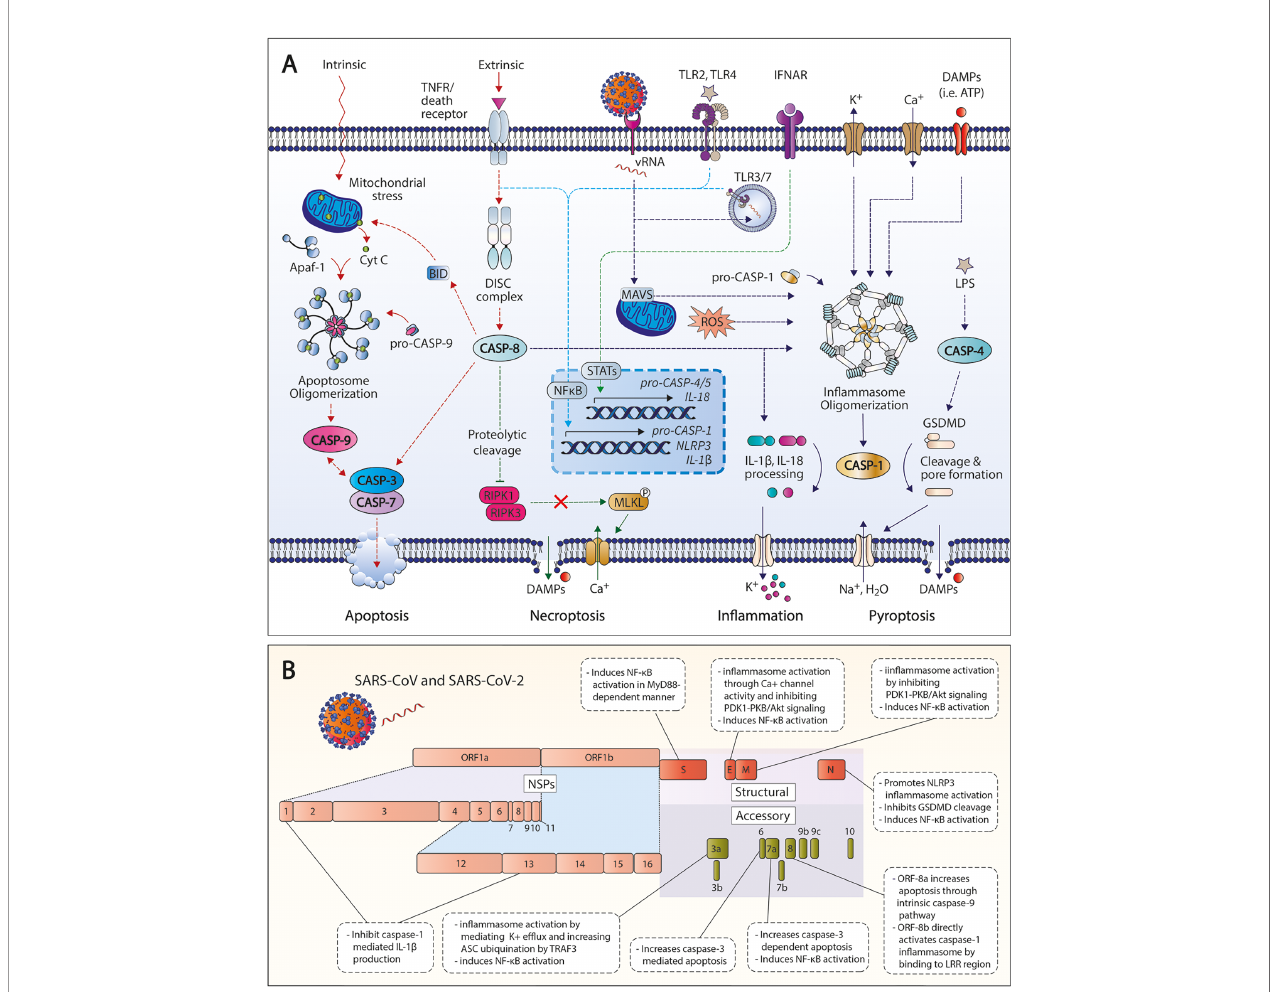
FIGURE 1 | Activated caspase pathways in SARS-CoV-2. (A) Apoptotic and in fl ammatory pathways associated with caspases in SARS-CoV-2 infection and COVID-19. (B) Structural, non-structural, and accessory proteins of SARS-CoV and SARS-CoV-2 that modulate caspase-related pathways. TNFR, tumor necrosis factor receptor; CASP, caspase; DISC, death-inducing signaling complex; GSDMD, gasdermin D; ROS, reactive oxygen species; LDH, lactate dehydrogenase; DAMPs, danger-associated molecular patterns; TNFR, tumor necrosis factor receptor; IFNAR, interferon a / b receptor; LPS, lipopolysaccharide; RIPK, receptor- interacting serine/threonine, protein kinase; MLKL, mixed lineage kinase domain-like protein; NSP, non-structural